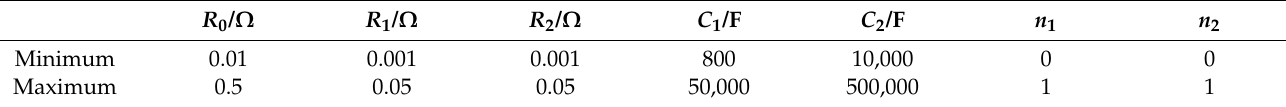
Table 4. The value range of model parameters.